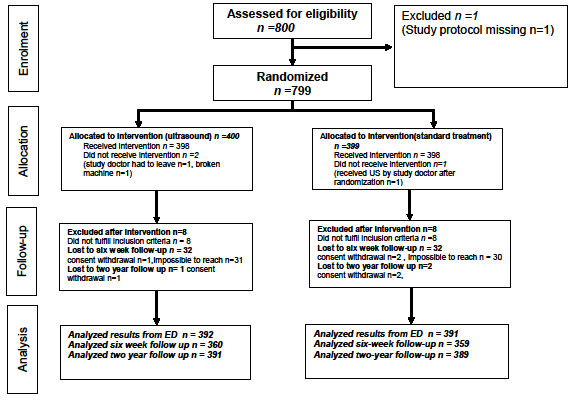
Study Flow Chart.